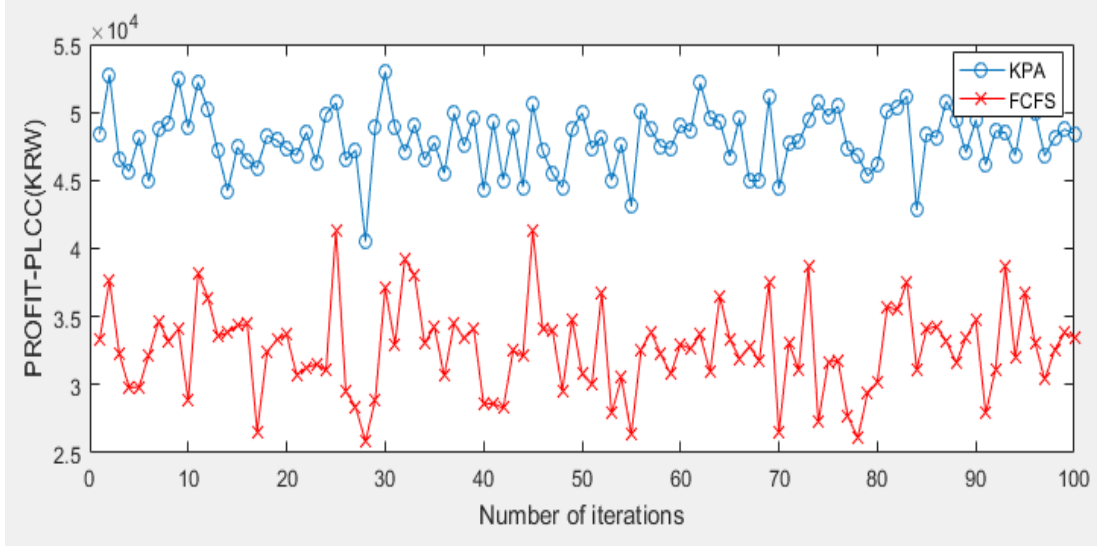
Figure 12. Results of total PROFIT for the PLCC in Case (8): demand 400 kW, 80 EVs.